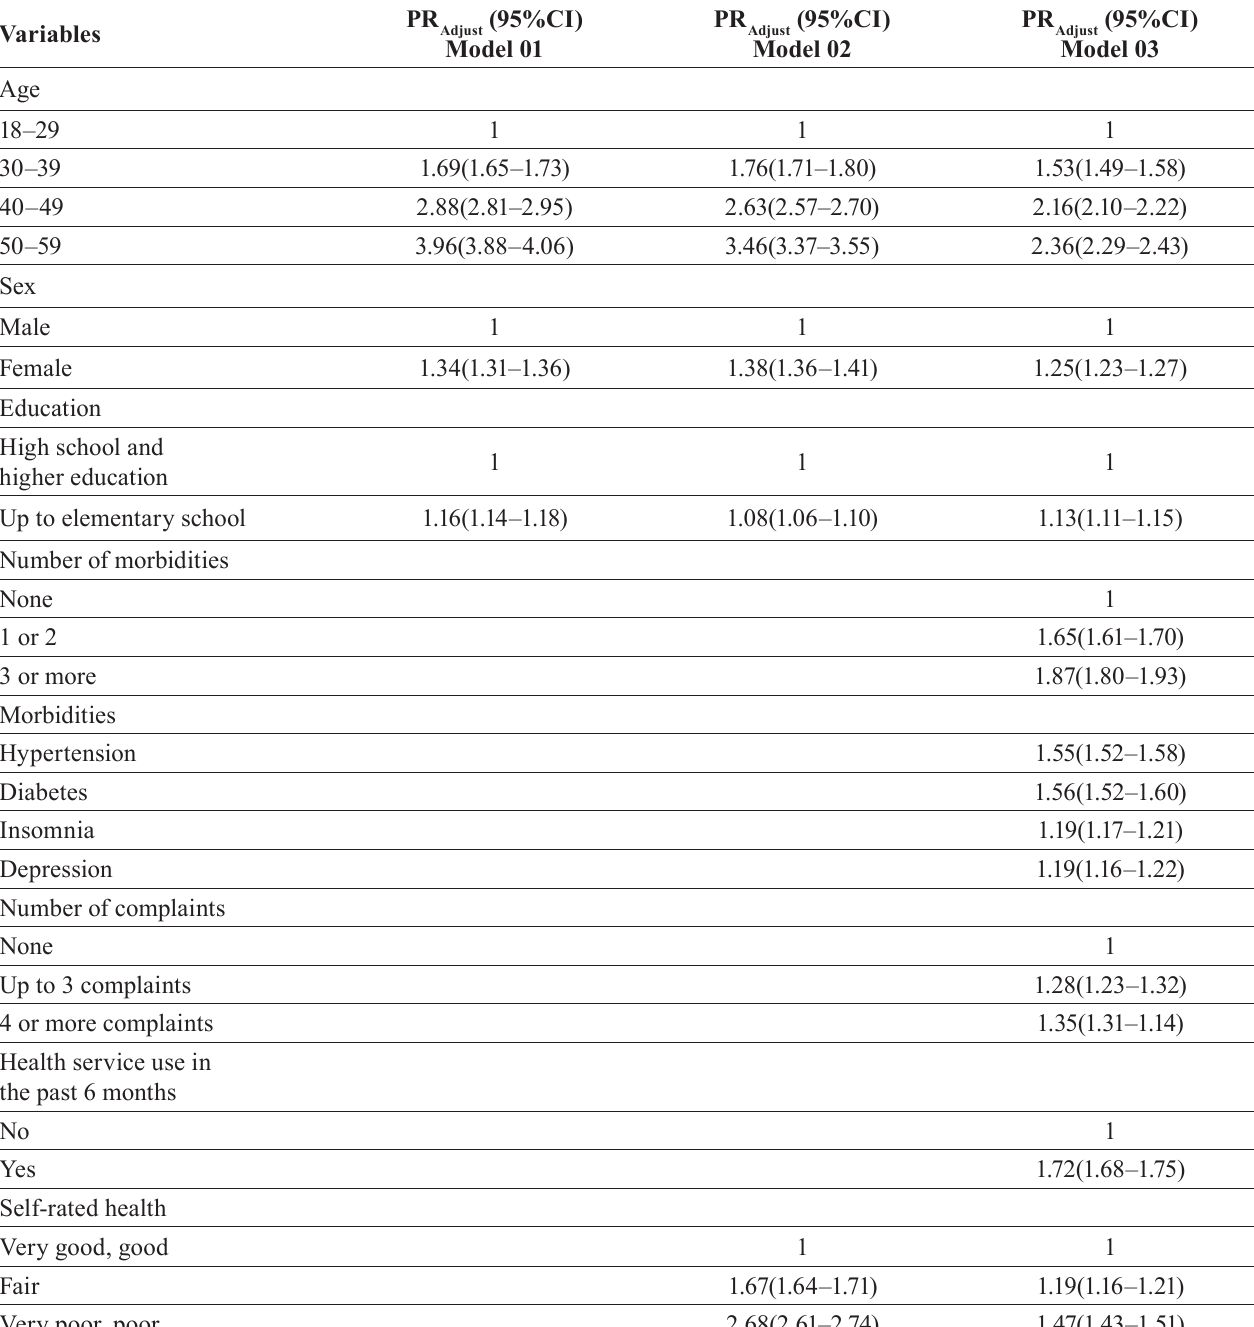
TABLE IV - Hierarchical adjusted models of medicine use according to independent variables of the adult in Rio Branco, AC, Brazil,